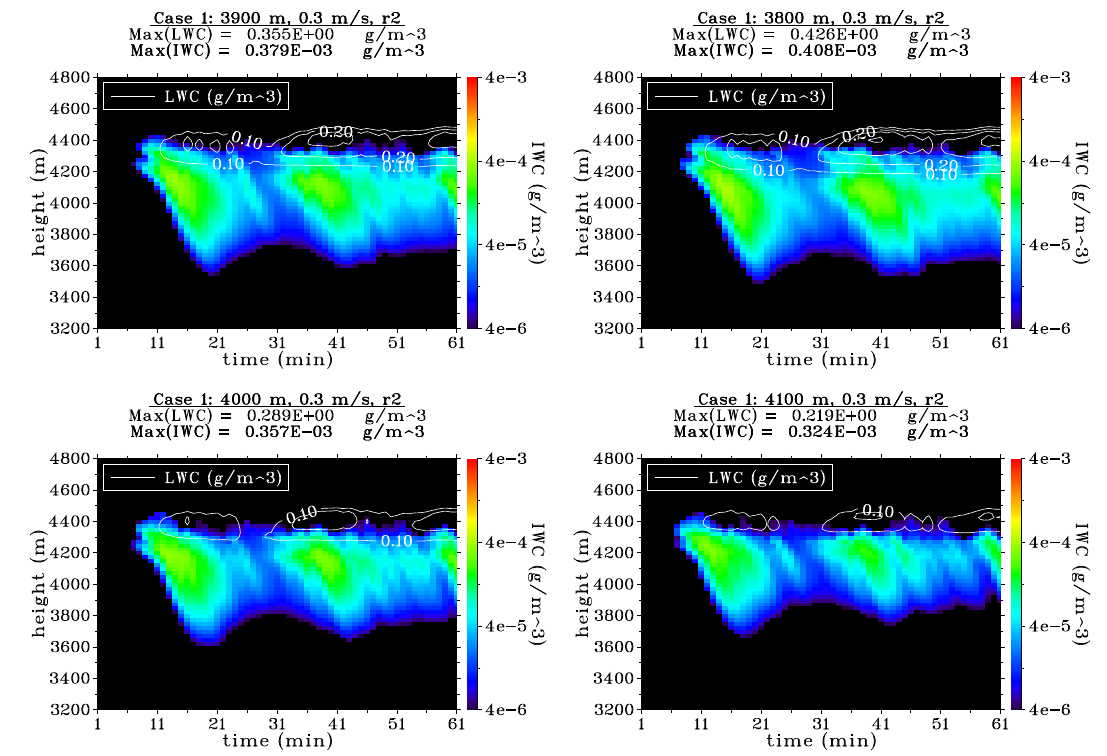
Figure 9. LWC (contours) and IWC (colors, logarithmic scale) for case 1. Comparison of different values for h bot (upper left: W_base, h bot = 3900m; upper right: W_h38, h bot = 3800m; lower left: W_h40, h bot = 4000m; lower right: W_h41, h bot = 4100m.)